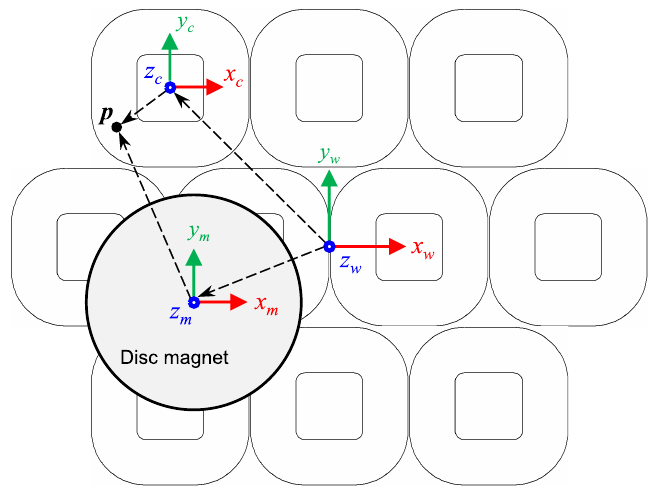
Figure 8. Coordinate systems: world coordinates { w }, coil coordinates { c }, and mover coordinates { m